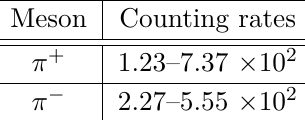
Table 2 . Estimated counting rates at COMPASS for π ± γ photoproduction.